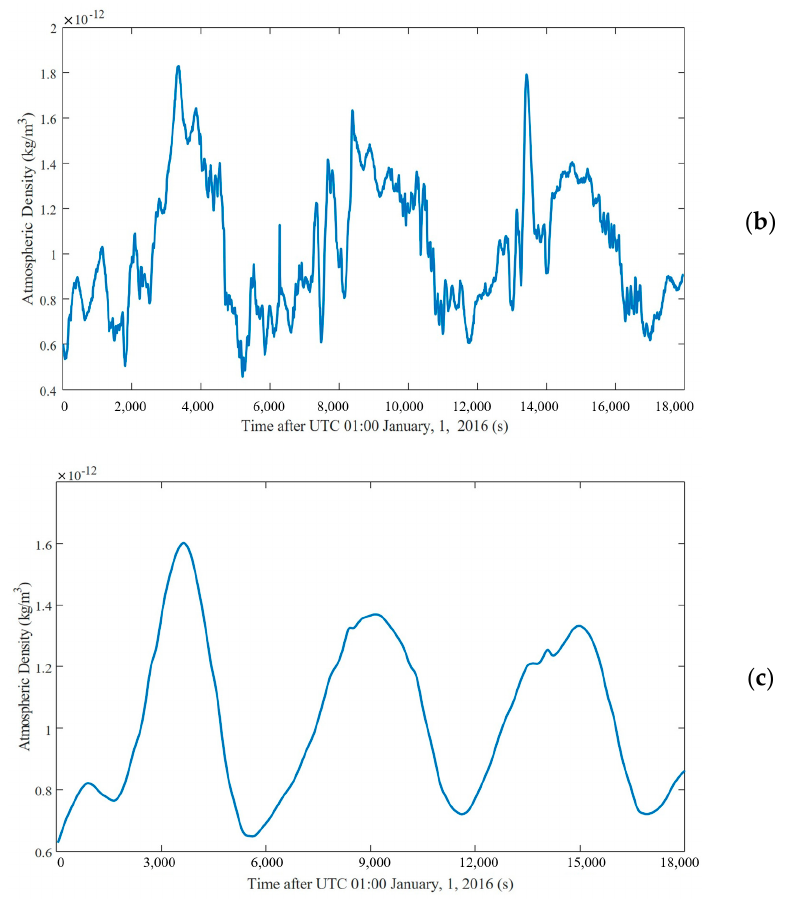
Figure 10. Atmospheric density time series obtained from Swarm-C satellite accelerometer data. ( a ) Our method; ( b ) accelerometer inversion results; ( c ) POD inversion results.